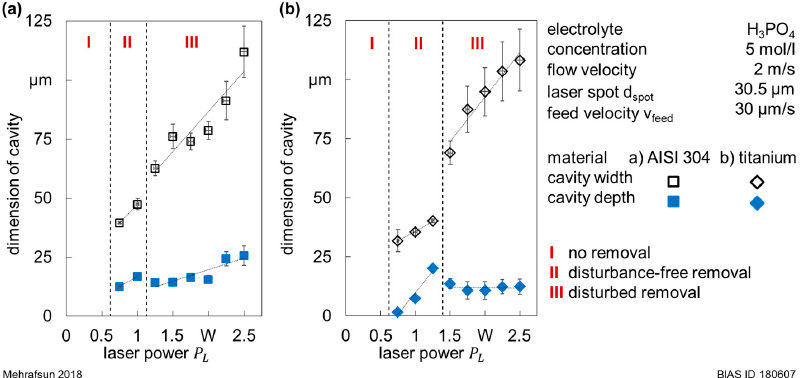
Figure 6. Width and depth of the resulting LCM cavities in ( a ) stainless steel and ( b ) titanium at a feed velocity v feed of 30 μ m/s in dependence of the applied laser power.